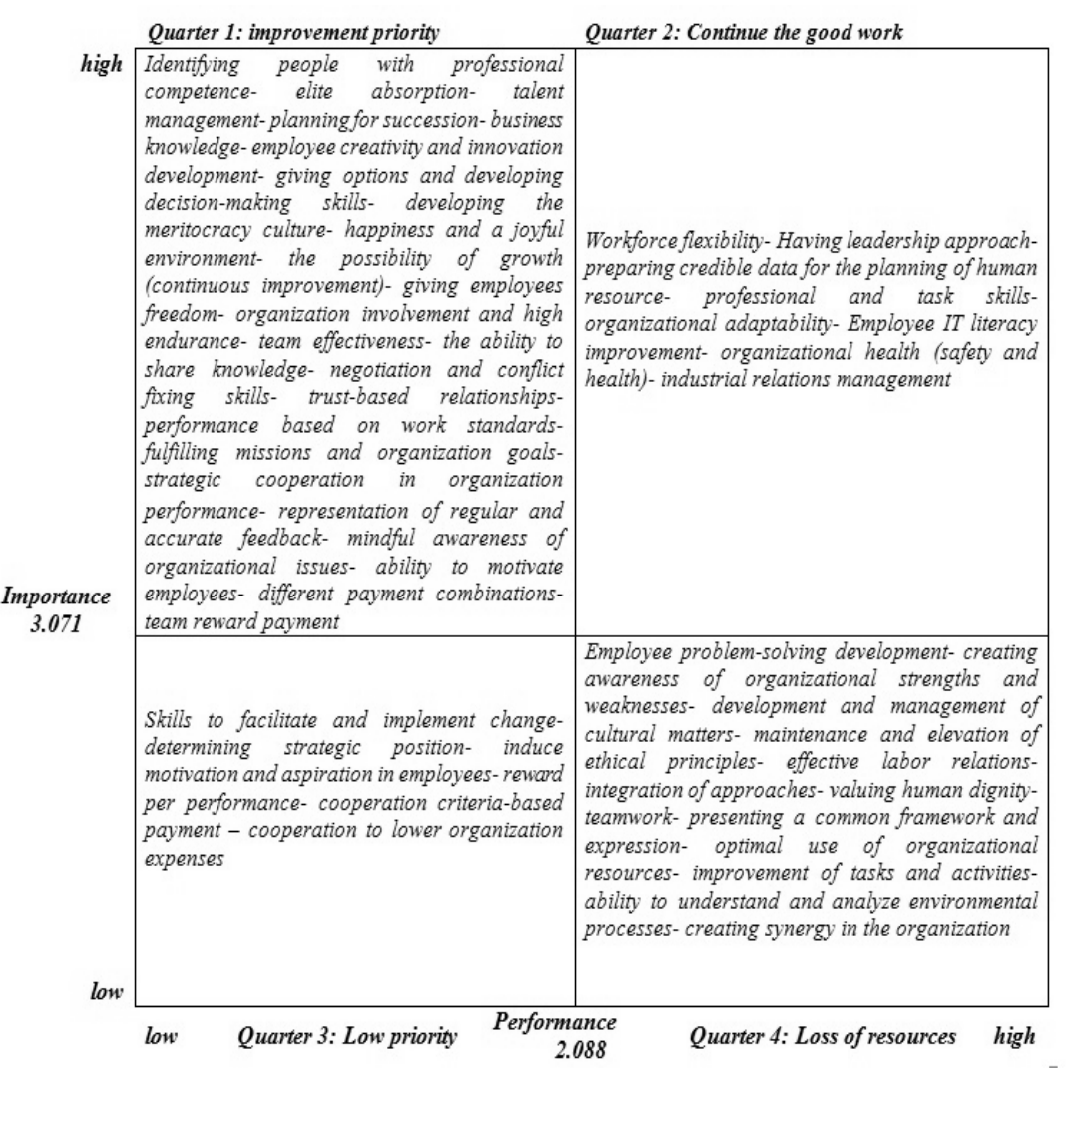
Fig. 1. The importance-performance matrix of the human resource management system based on international and global